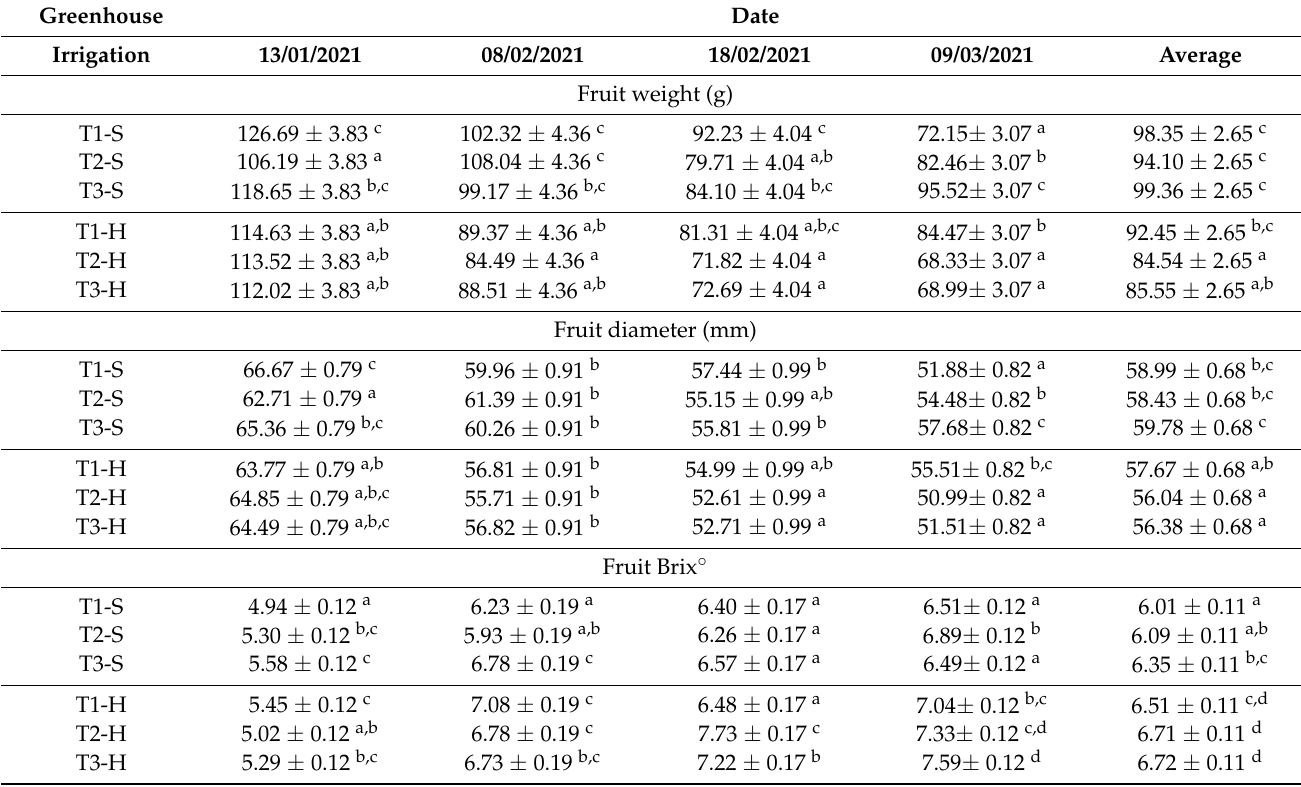
Table 5. Fruit weight, diameter and Brix degrees in different harvest times and average value for the crop